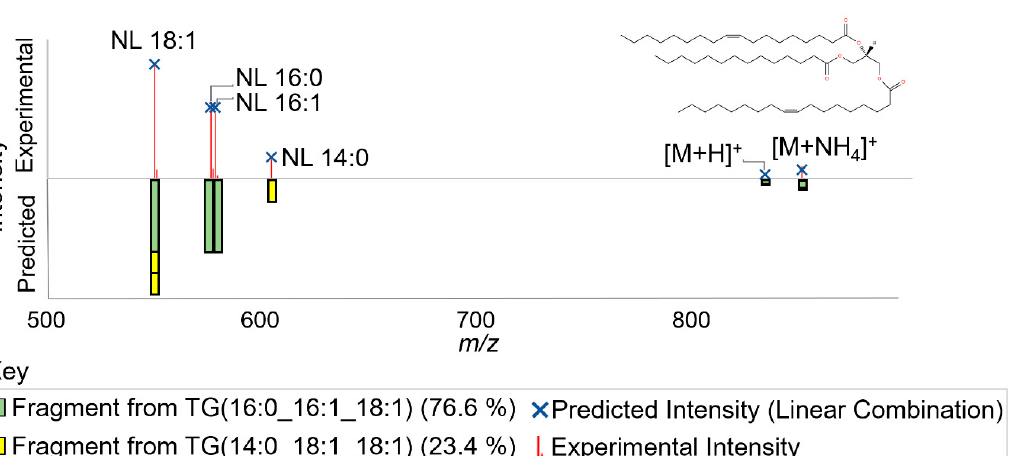
Figure 3. Example of the approximation of percent contribution to a mixed MS / MS spectra of two triglyceride isomers with 50 carbons and 2 degrees of unsaturation, triglyceride TG(50:2), using a negative least squares best fit. Example is from NIST SRM 1950 in positive ion mode.